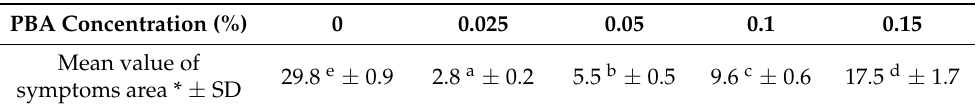
Figure 4. Early blight symptoms on tomato plants pretreated with PBA, measured by software ImageJ 14 days after inoculation with Alternaria alternata . Table 7. Effect of tomato plants pretreatment with PBA on the severity of early blight symptoms, caused by Alternaria alternata 14 days post-inoculation.